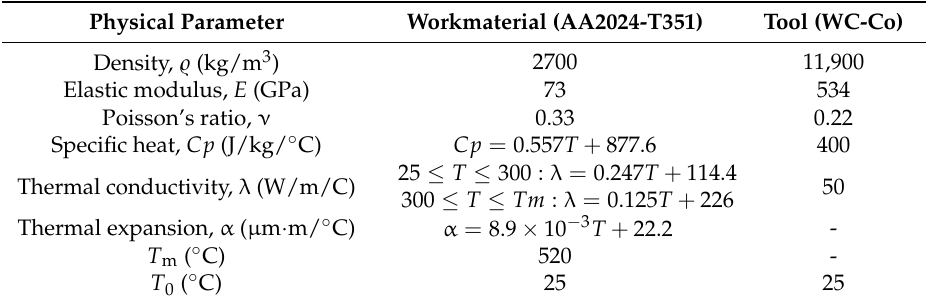
Table 3. Mechanical and thermal properties of work material and tool [6].